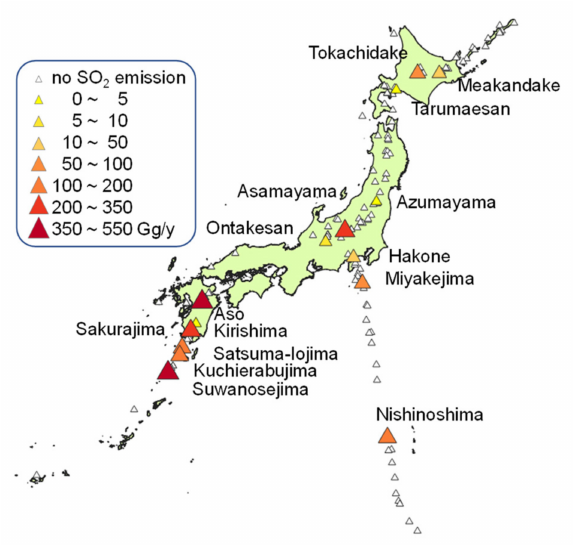
Figure 10. Active Japanese volcanos [23] and SO 2 emissions from volcanoes (2015).